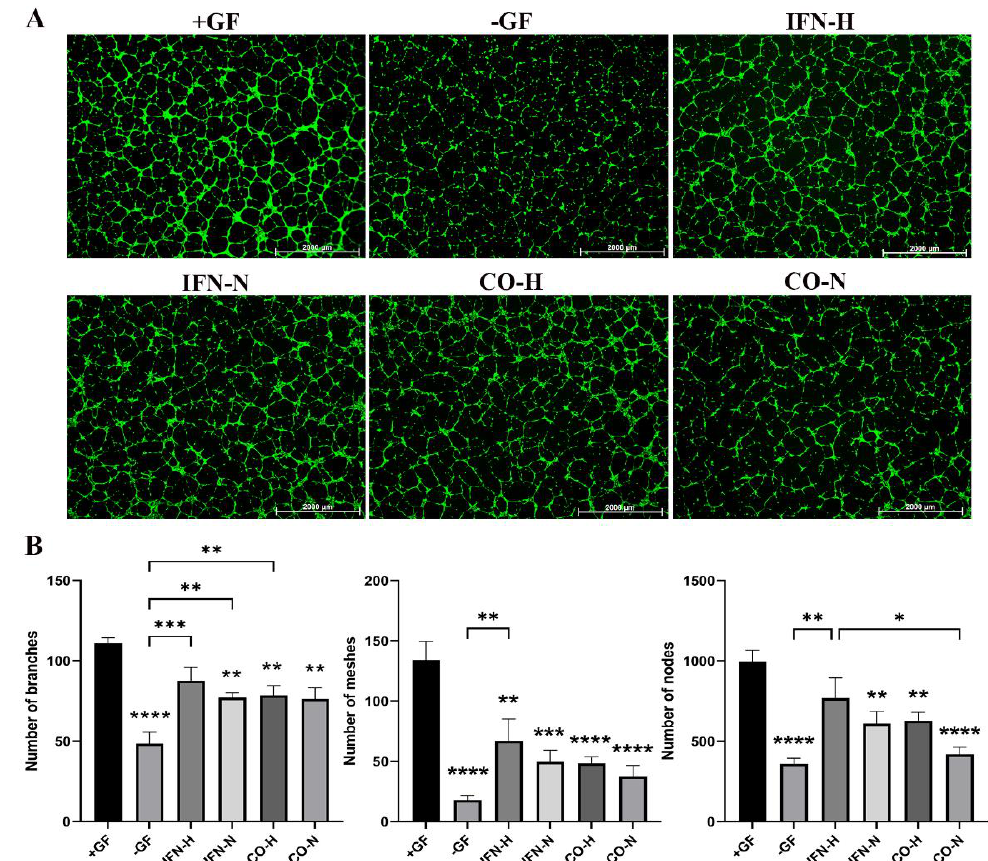
Figure 5. Tube formation of HUVECs incubated with secretomes obtained from differently pre-conditioned iMSCs. HUVECs seeded onto the Geltrex matrix in a medium containing secretomes from differently pre-conditioned iMSCs, growth factors (+GF, positive control group), or without growth factors ( − GF, negative control group). ( A ) Representative images (1.25 × magnification, scale bar = 2000 µm) of tube formation were taken using fluorescent microscopy (calcein-AM green staining), 8 h after cell seeding. ( B ) Number of branches, number of meshes, and number of nodes were quantified with the ImageJ software. Values represent means ±SEM from three independent experiments (*, **, ***, **** without bar indicates significant differences to the +GF group; * p < 0.05, ** p < 0.01, *** p < 0.001, **** p < 0.0001).